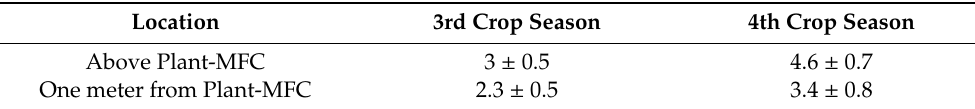
Table 2. Average aboveground wet biomass (kg / m 2 ).